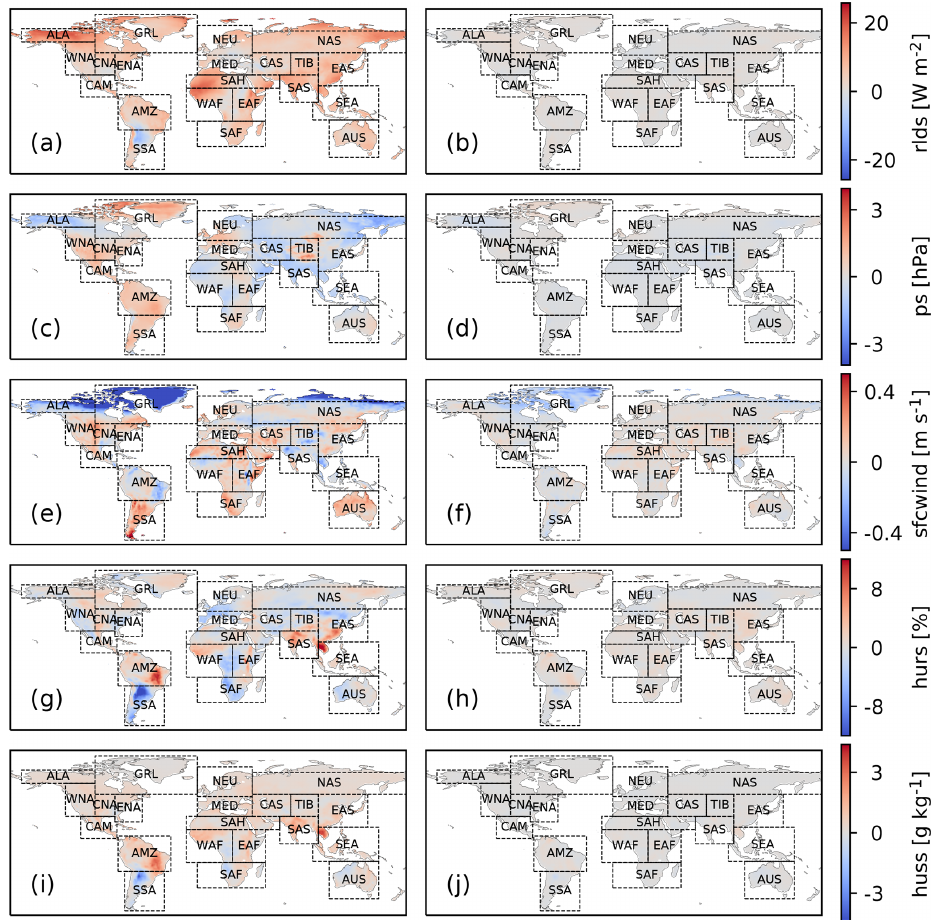
Figure 6. Same as Fig. 5 but for rlds, ps, sfcwind, hurs and huss. Note that the color scale is capped for wind at − 0.5 and 0.5ms − 1 and for hurs at − 12% and 12%. Values below and above those bounds are displayed in dark blue and dark red,